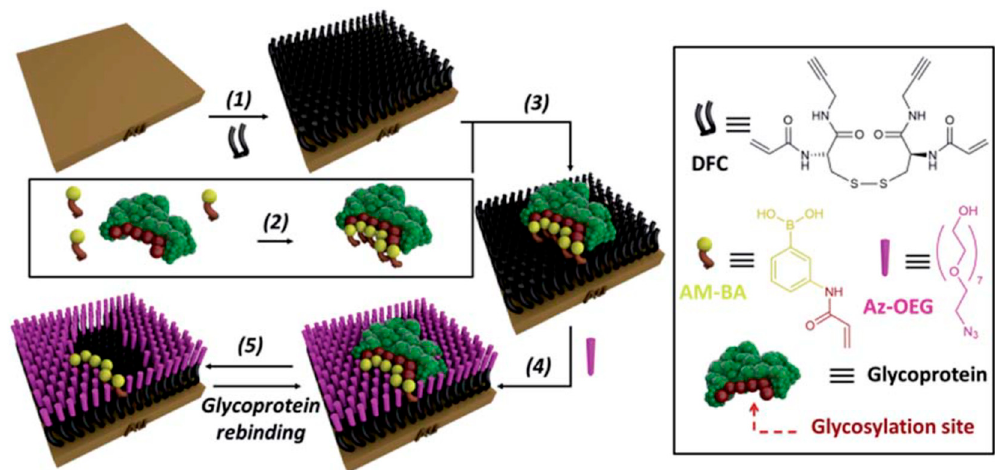
Figure 14. Selective glycoprotein detection using boronate-based imprinting approach. Strategy for the fabrication of glycoprotein-imprinted surfaces using acrylamido-boronic acids (AM-BAs); ( 1 ) self-assembled monolayer (SAM) formation on a gold surface with DFC molecule; ( 2 ) incubation of the AM-BA receptors with the template target glycoprotein; ( 3 ) grafting of the preformed boronic acid–glycoprotein complex on the SAM via acrylamide co-polymerization; ( 4 ) azide-terminated oligoethylene glycol (Az-OEG) functionalization to provide glycoprotein-shaped cavities; ( 5 ) removal of the template protein, affording a nanocavity specific for the target glycoprotein. Reproduced from ref. [192] under a Creative Commons Attribution